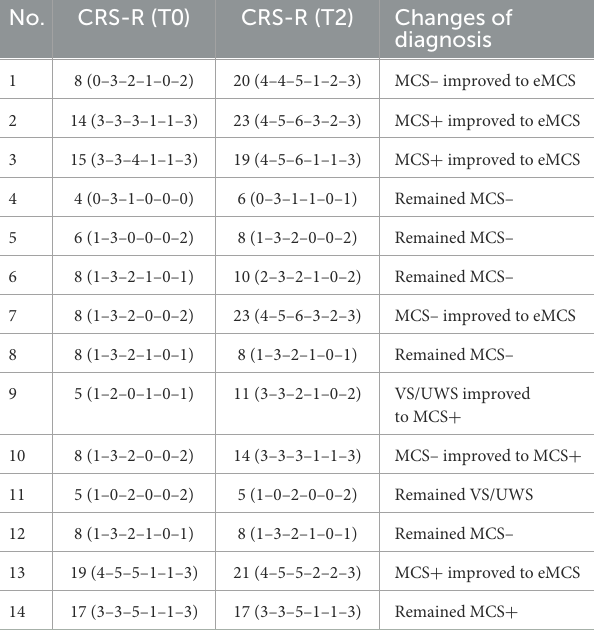
TABLE 2 Description of items included in the CRS-R. TABLE 3 Clinical data of patients with disorders of consciousness treated by short-term spinal cord stimulation.